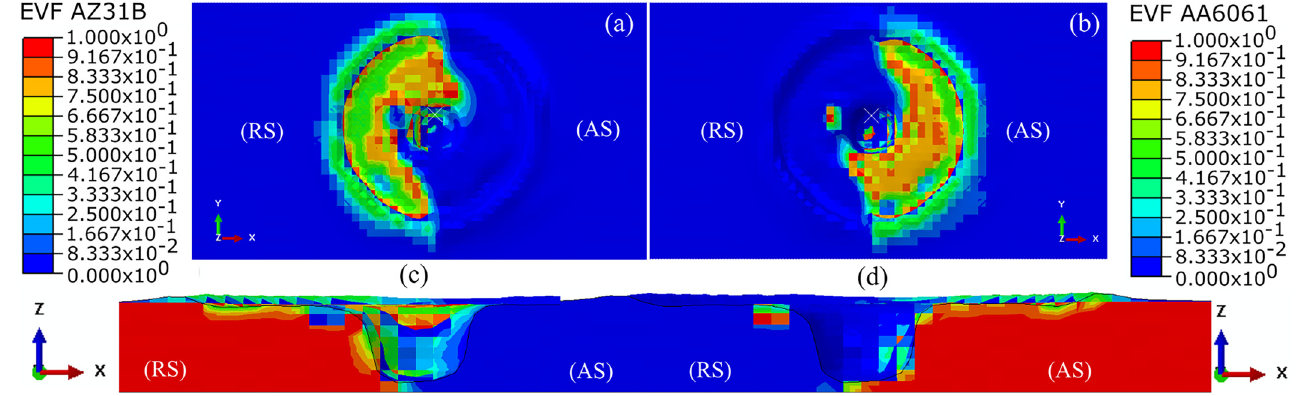
Figure 3. Numerical modeling of the material flow on top surface of SZ ( a ) RS ( b ) AS; and the cross-section ( c ) RS and ( d ) AS at end of the dwell stage at 900 rpm.